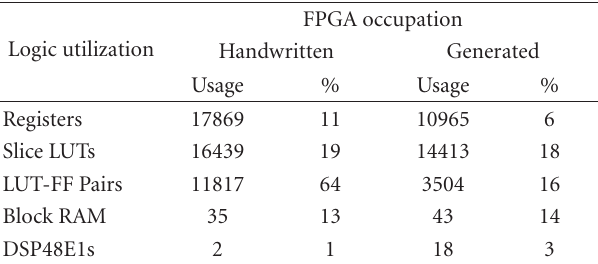
Table 4: FPGA occupation of the handwritten VHDL JPEG encoder versus the RVC-CAL JPEG Encoder.